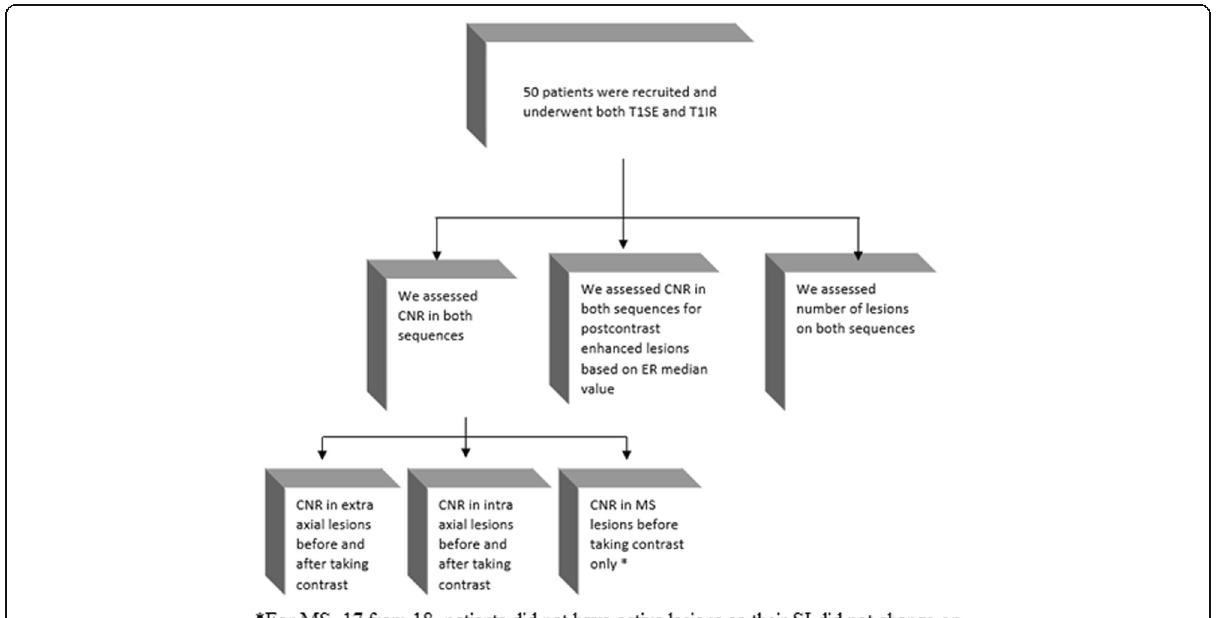
Fig. 1 Flow chart of data